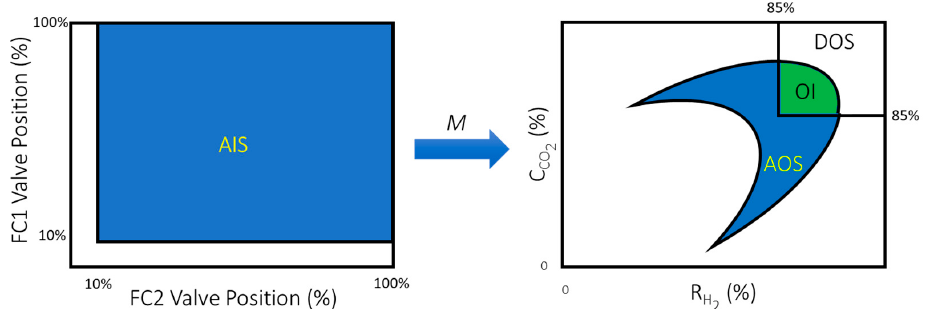
Figure 14. A general visualization for the WGS-MR case being studied. Here, the AIS is defined as the set of all control valve positions available and the DOS is defined as the set of all operating points with greater than 85% for both hydrogen recovery and carbon capture.